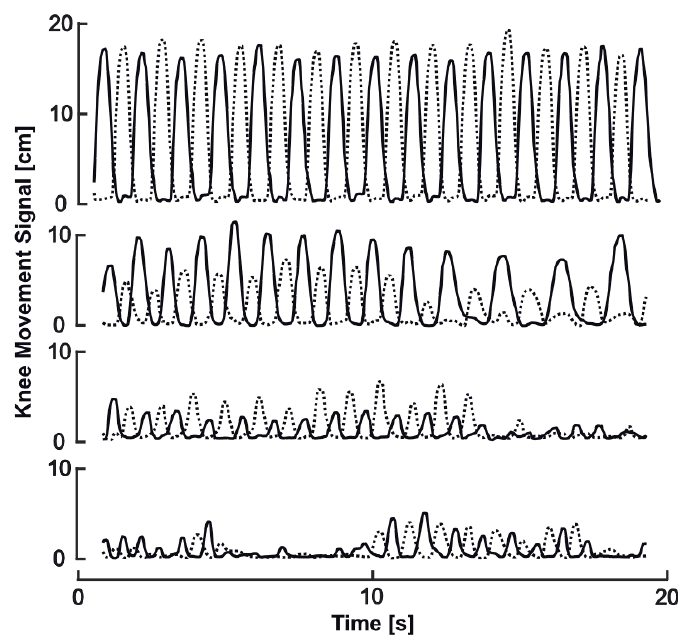
Figure 5. Illustration of freezing of gait (FOG) related changes on SIP behavior from our sample: normal rhythmic stepping behavior of regular and symmetric amplitude ( top ); hesitations of stepping with asymmetrical inconsistent stepping behavior and slowing of movements at the end ( second from top ); progressively ine ff ective stepping with small movement, asymmetry, and freezing of stepping at the end ( third from top ); ine ff ective highly irregular low-amplitude stepping and freezing of stepping in first half and at the end ( bottom ).